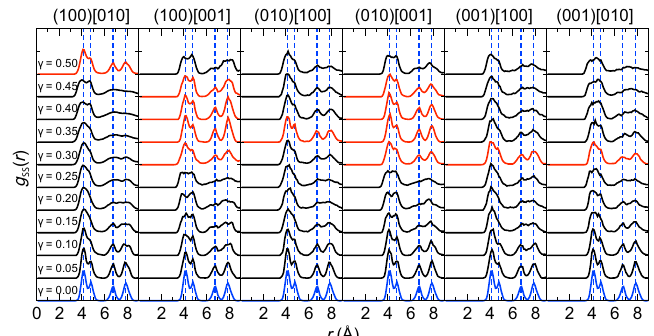
Figure 3. Partial radial distribution functions g SS ( r ) of sulfur-sublattice during shear deformation. The blue solid curve and dashed line indicates the g SS ( r ) of non-sheared state and its peak positions, respectively. The red curves shows at which the peak positions were recovered. The g SS ( r ) was calculated using latest 500 MD step (= 0.5 ps) for each γ